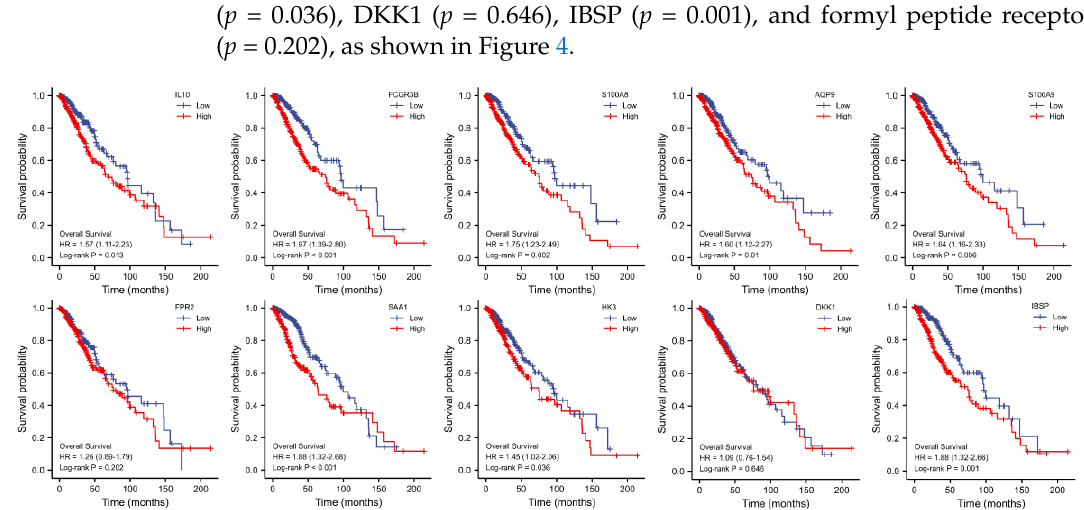
Figure 4. Survival analysis in relation to 10 key genes.